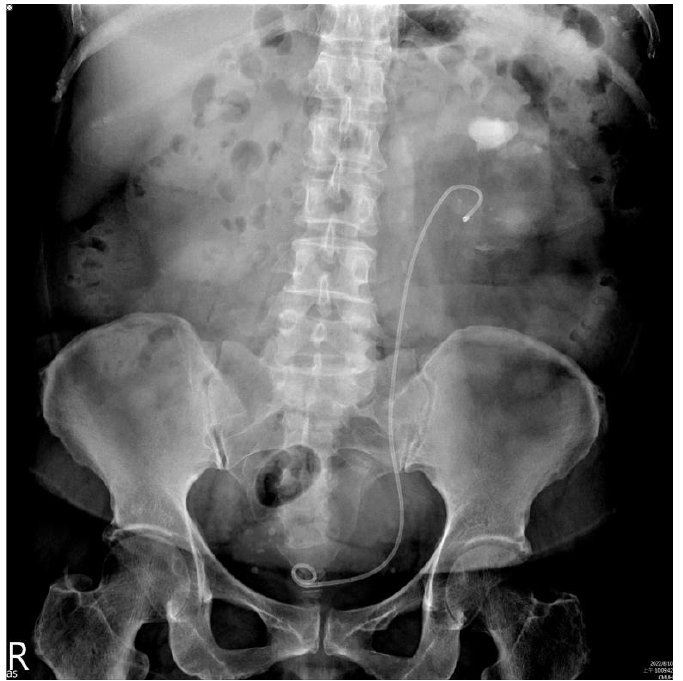
Figure 5. Postoperative findings of a kidney, ureter and bladder radiograph suggest a residual stone about 24 mm in size.